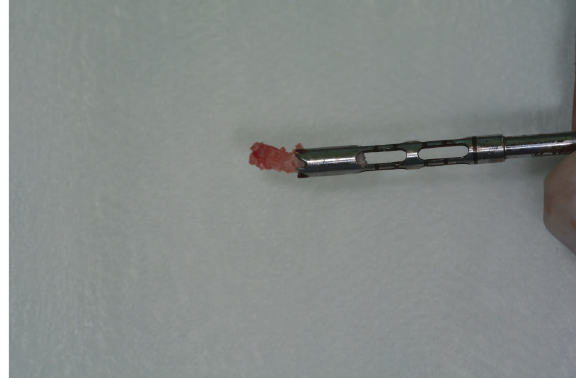
Figure 7: Bone specimens removed by a trephine bur.